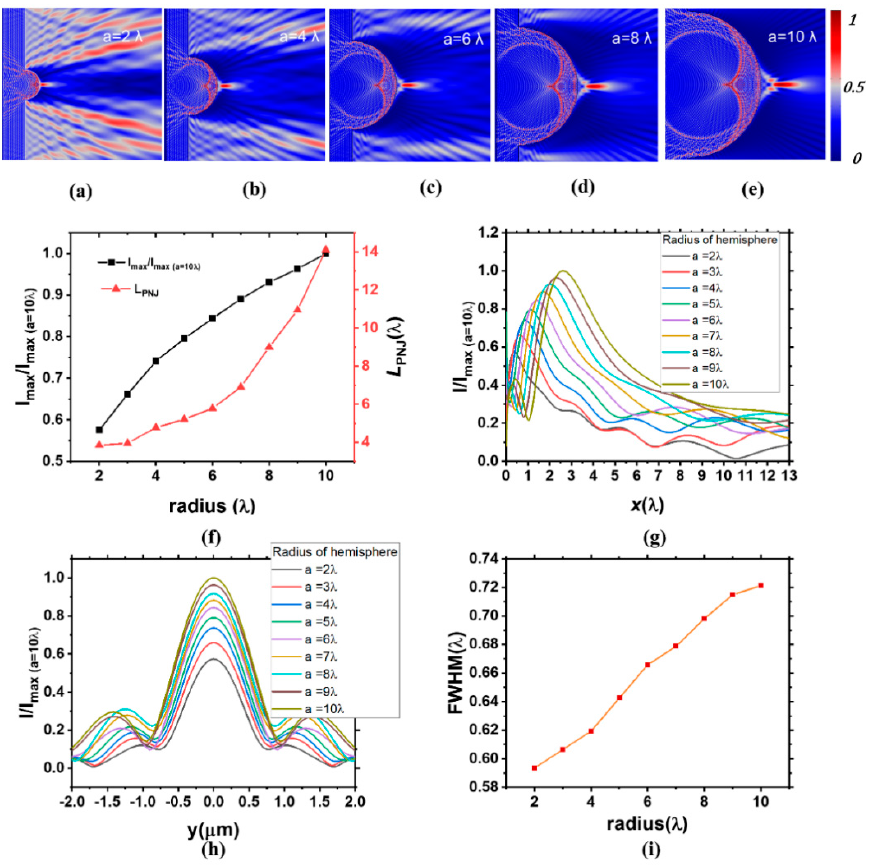
Figure 3. PNJ generated by hemispherical domes of different radii ( a – e ). The maximum intensity ( I max ) normalized to I max of dome of a = 10 λ and the L PNJ as a function of radius are shown in ( f ). Normalized electric field intensity along the length of PNJ is shown in ( g ). Normalized electric field intensity across the beam waist and FWHM as a function of radius are shown in ( g − i ), respec- tively.